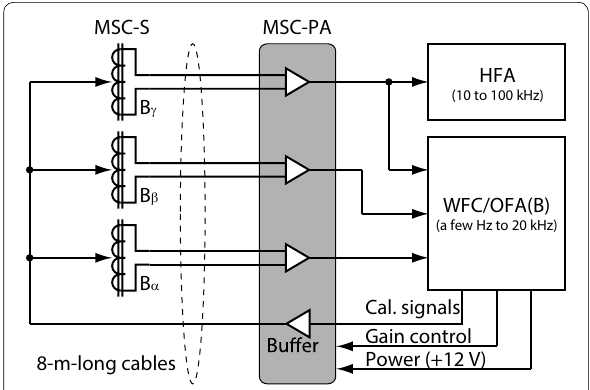
Fig. 3 Block diagram of the MSC on board the Arase satellite Table 2 NEMI requirements for the